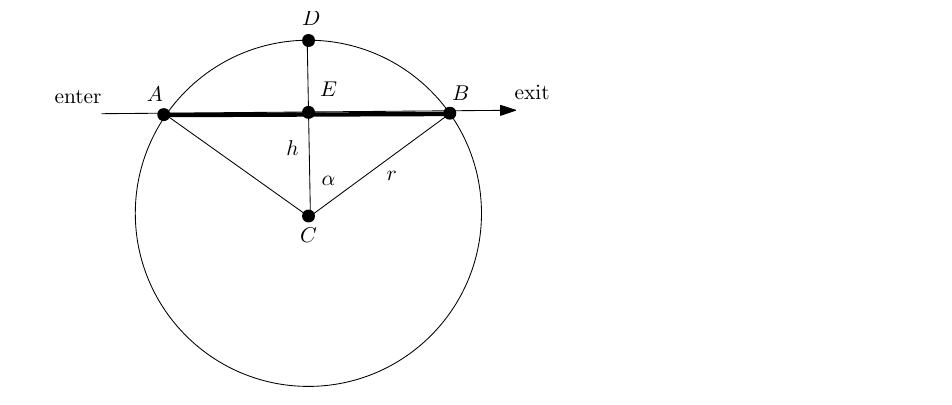
Figure 7. A drone M is traversing a straight line trajectory from A (entrance) to B (exit) at distance h from the point C . Its path inside the circle is depicted by the thick segment AB